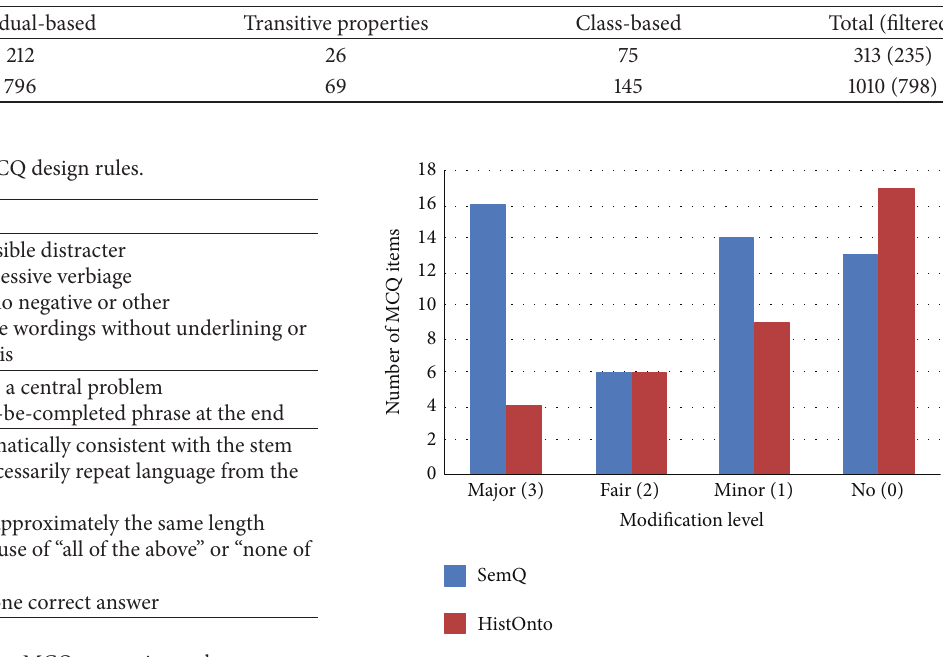
Figure 2: Modification level